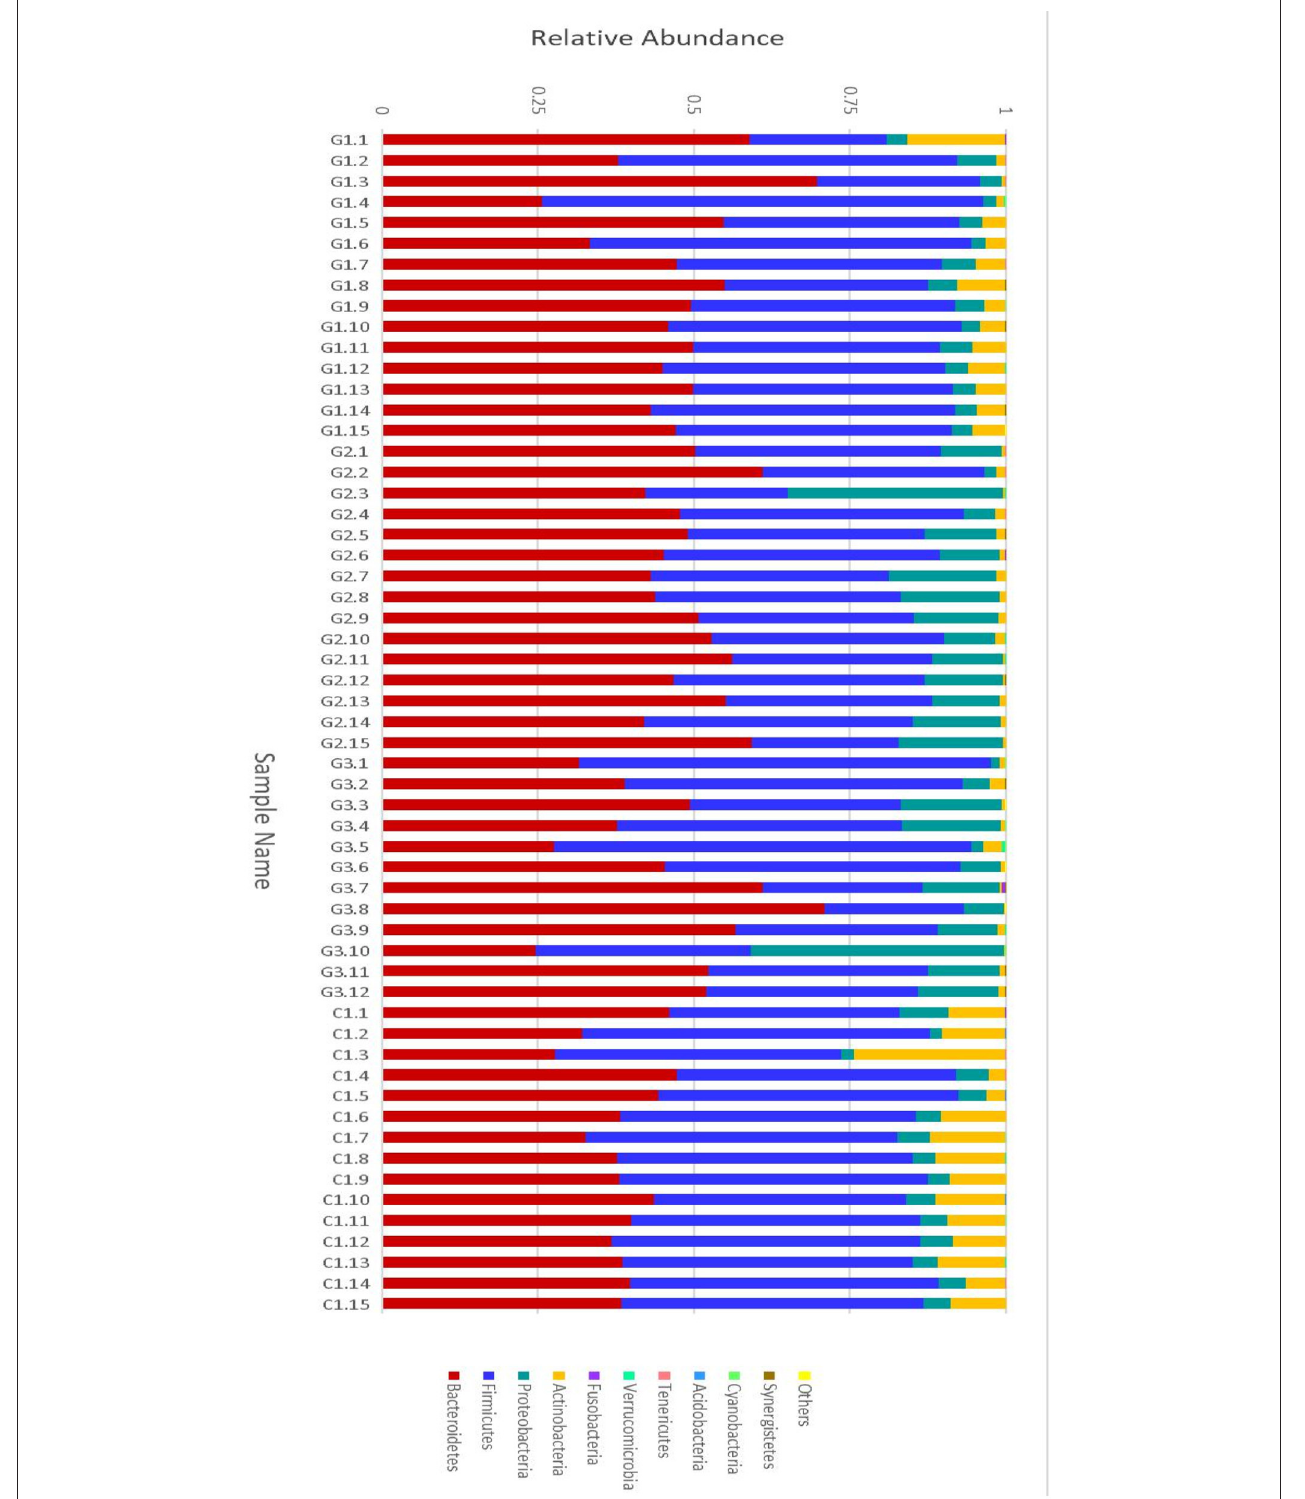
FIGURE 2 | Relative abundance of the intestinal flora at the family level in children. The abscissa is the sample name; the ordinate indicates the relative abundance; “Others” represents the sum of the relative abundance of all the orders of the 10 largest phyla with the highest relative abundance (The maximum relative abundance of a phylum in all